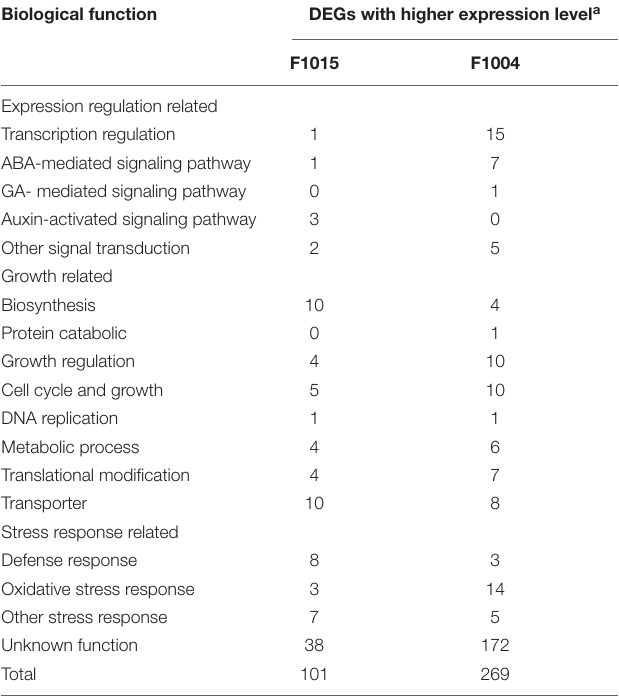
TABLE 6 | Comparison of the biological functions of genes that were differentially expressed in seedballs of sugarbeet lines F1004 and F1015 during germination induced using a 1% H 2 O 2